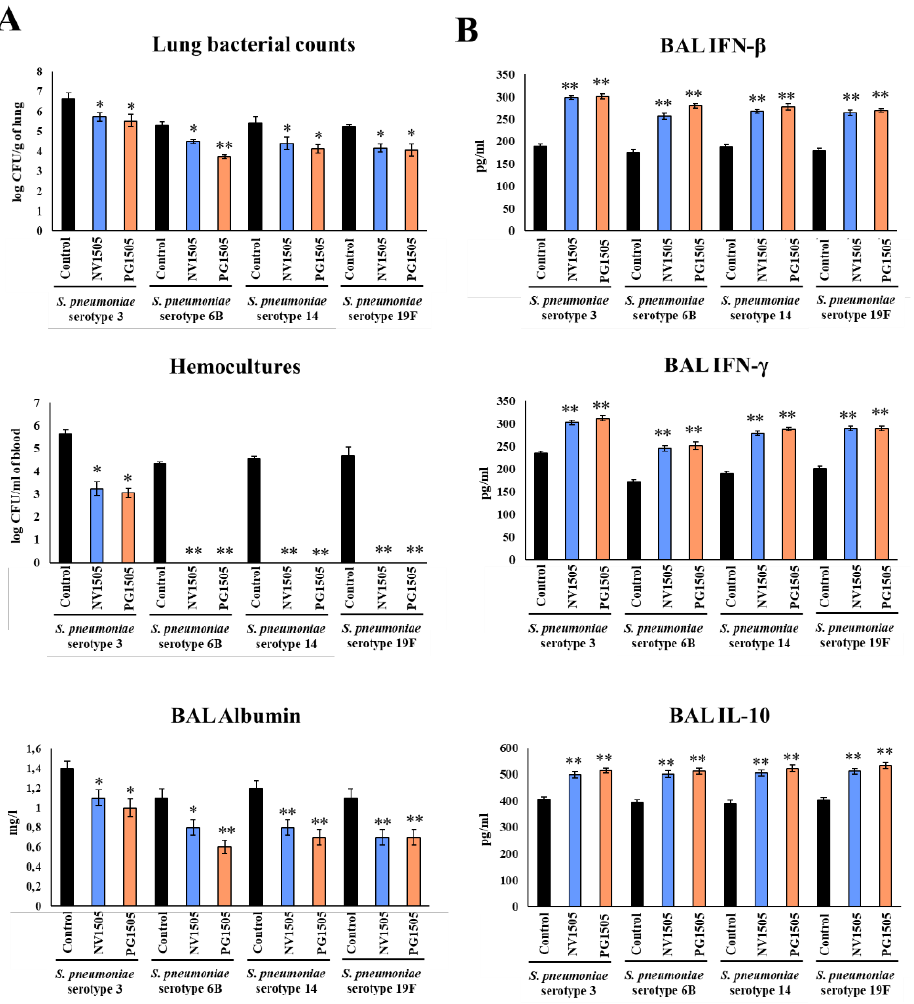
Figure 8. Ability of non-viable L. rhamnosus CRL1505 (NV) and its peptidoglycan (PG) to enhance resistance to secondary pneumococcal pneumonia produced by S. pneumoniae serotypes after poly(I:C) stimulation. Infant mice were nasally primed with NV1505 or PG1505 for two consecutive days, then stimulated with three once-daily doses of poly(I:C) and finally challenged with S. pneumoniae serotype 3, 6B, 14 or 19F five days after the last administration of poly(I:C). Non-treated infant mice stimulated with poly(I:C) and then challenged with the respective strains of S. pneumoniae were used as controls. ( A ) Lung bacterial cell counts, hemocultures and albumin concentrations in bronchoalveolar lavages (BAL) as well as ( B ) the levels of interferon (IFN)- β , IFN- γ and interleukin (IL)-10 in BAL were determined on day 2 post-pneumococcal challenge. The results represent data from three independent experiments. Asterisks indicate significant differences between treated and control groups; * ( p < 0.05) and ** ( p < 0.01).